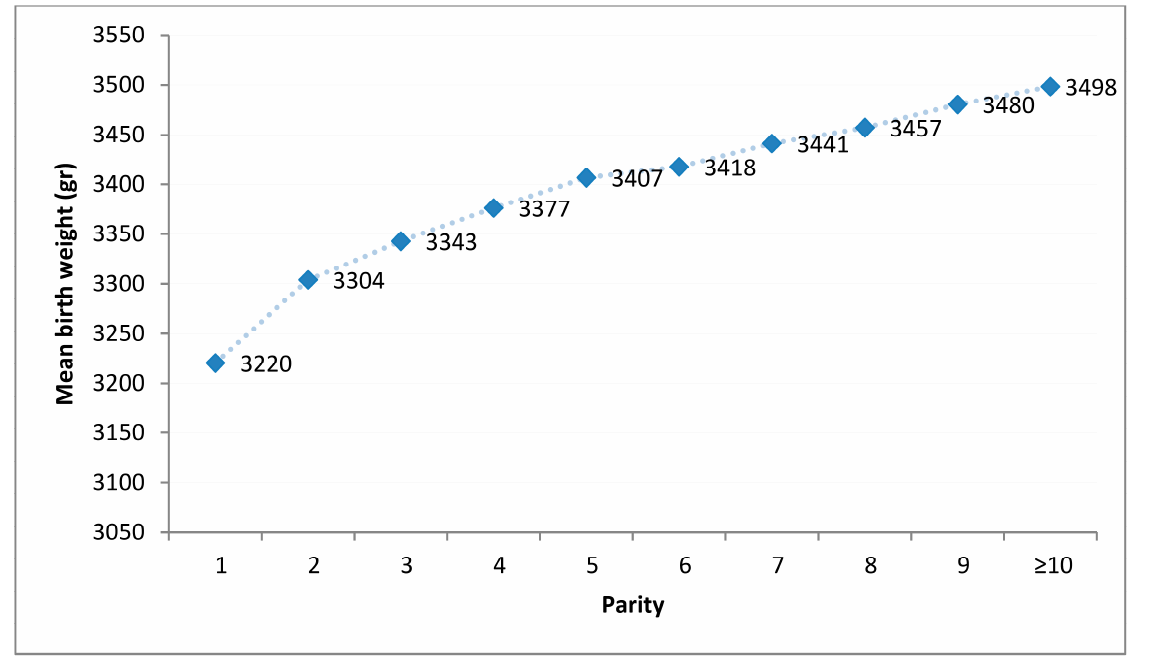
Figure 2. Birth weight by parity for the entire study cohort (mean birth weight).